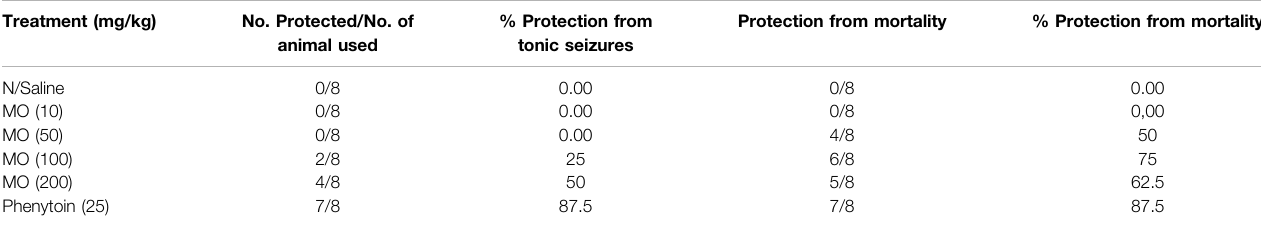
TABLE 2 | Effects of Melissa of fi cinalis L. essential oil (MO) on maximal electroshock (MES)-induced seizures in mice. Treatment (mg/kg) No. Protected/No. of % Protection from Protection from mortality % Protection from animal used tonic seizures